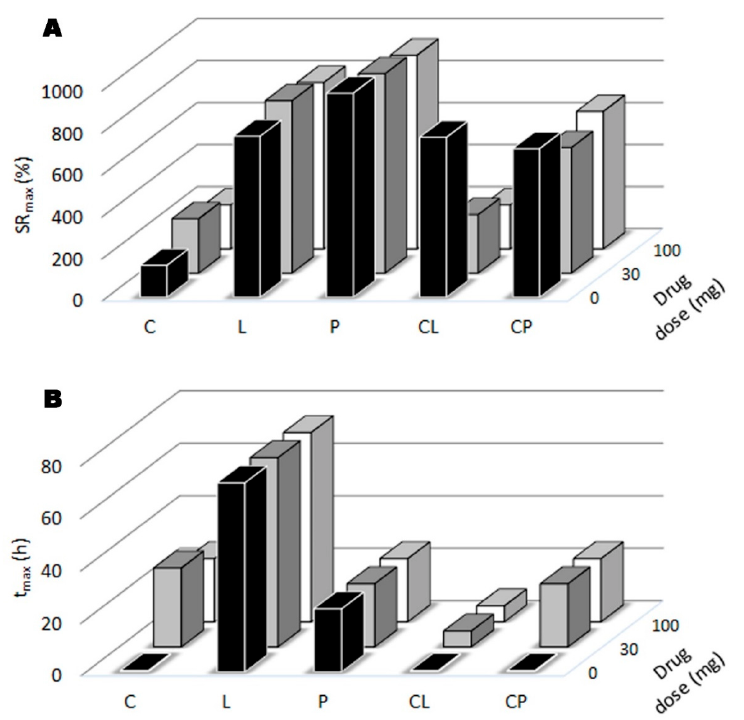
Figure 4. Maximum swelling ratio, SR max ( A ) and time required to achieve SR max , t max ( B ) for the tablets assayed. Pharmaceutics 2019 , 11 , x FOR PEER REVIEW